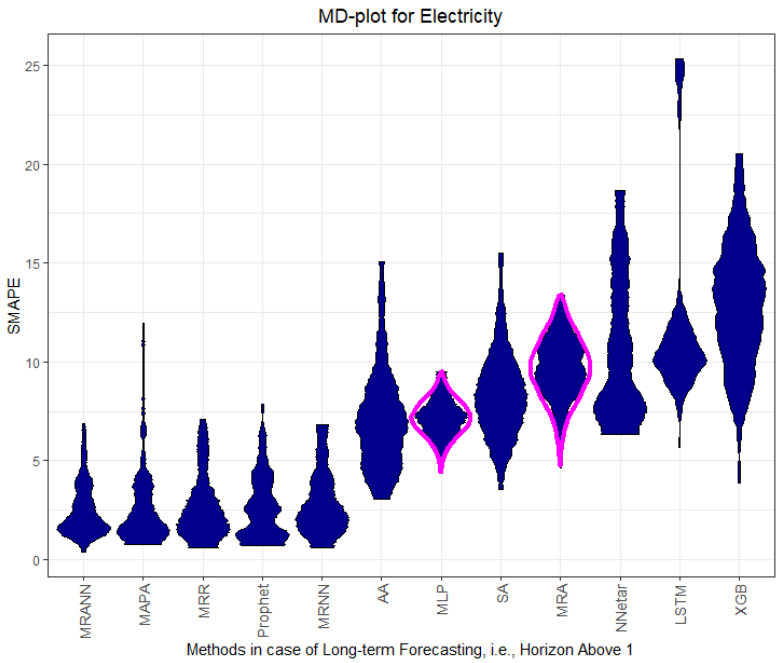
Figure A7. Mirrored density plot of Symmetric Mean Absolute Percentage Errors (SMAPE) computed with a rolling forecasting origin over all horizons on dataset Electricity. The estimated distributions showing a magenta marking are approximately gaussian distributed